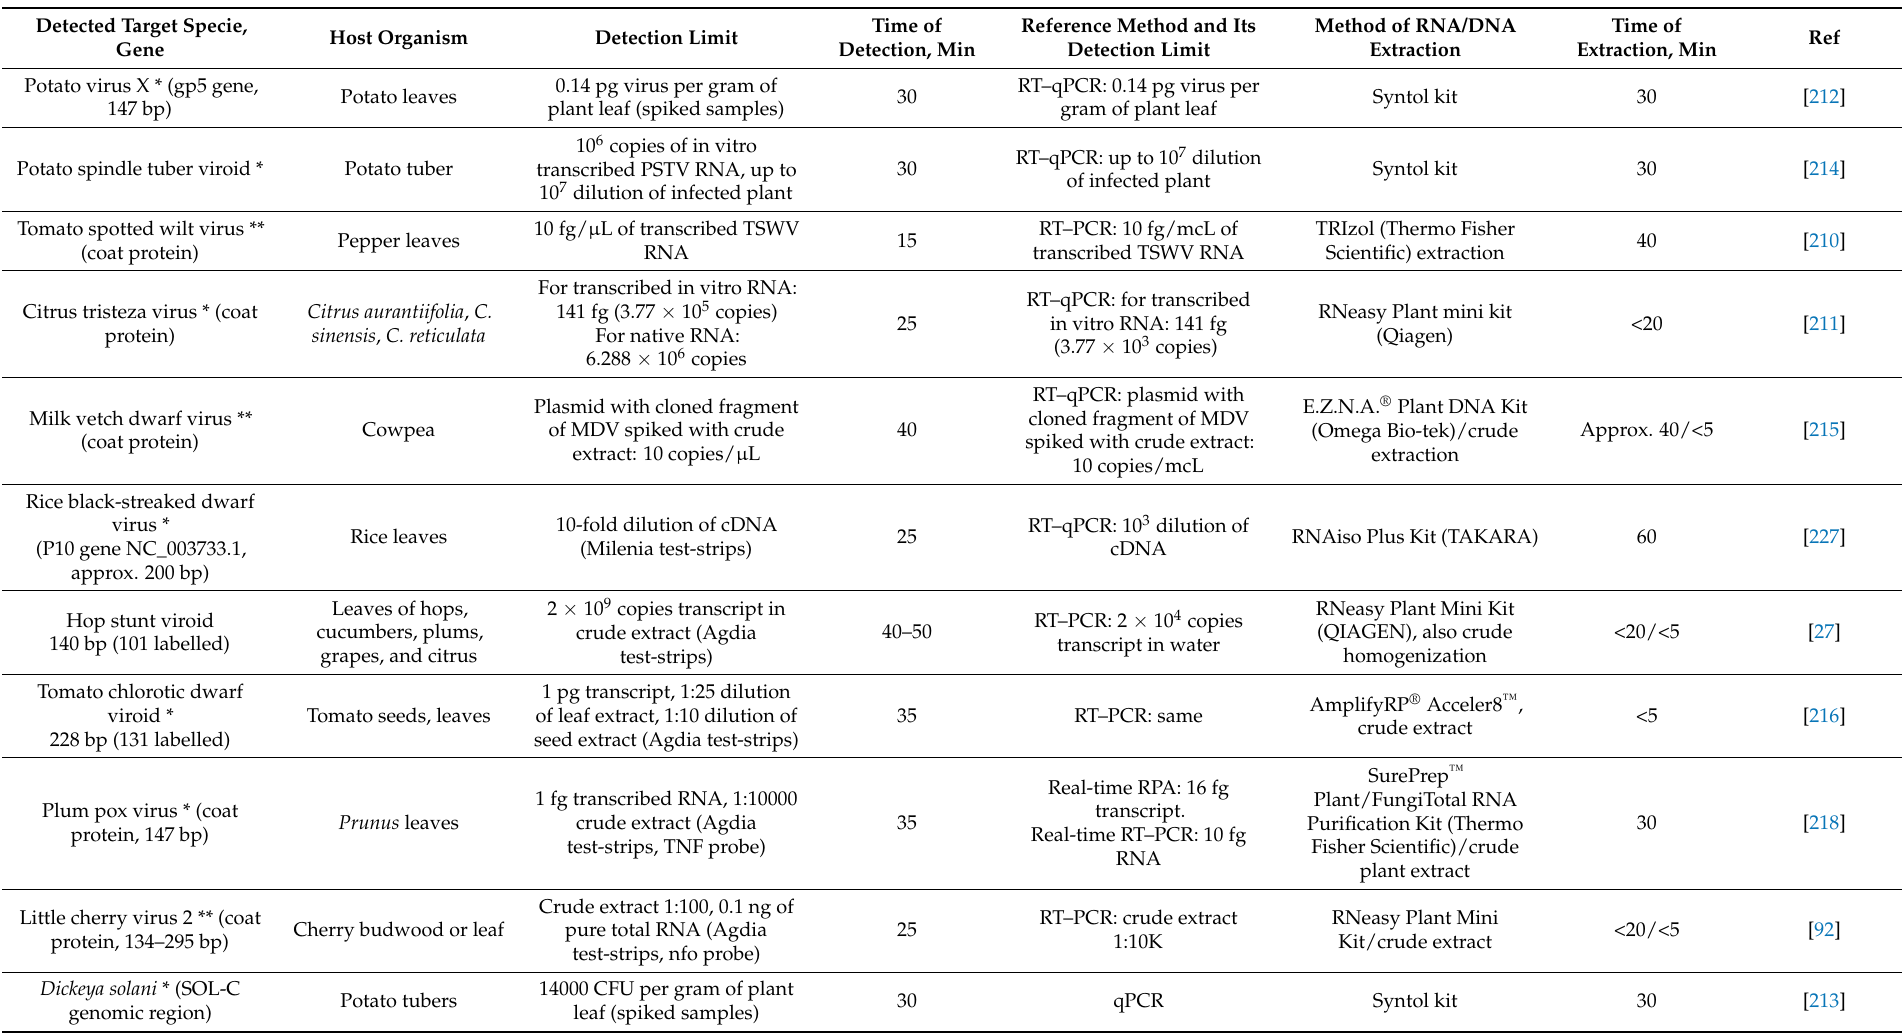
Table 1. Combination of RPA–LFA methods for plant pathogen